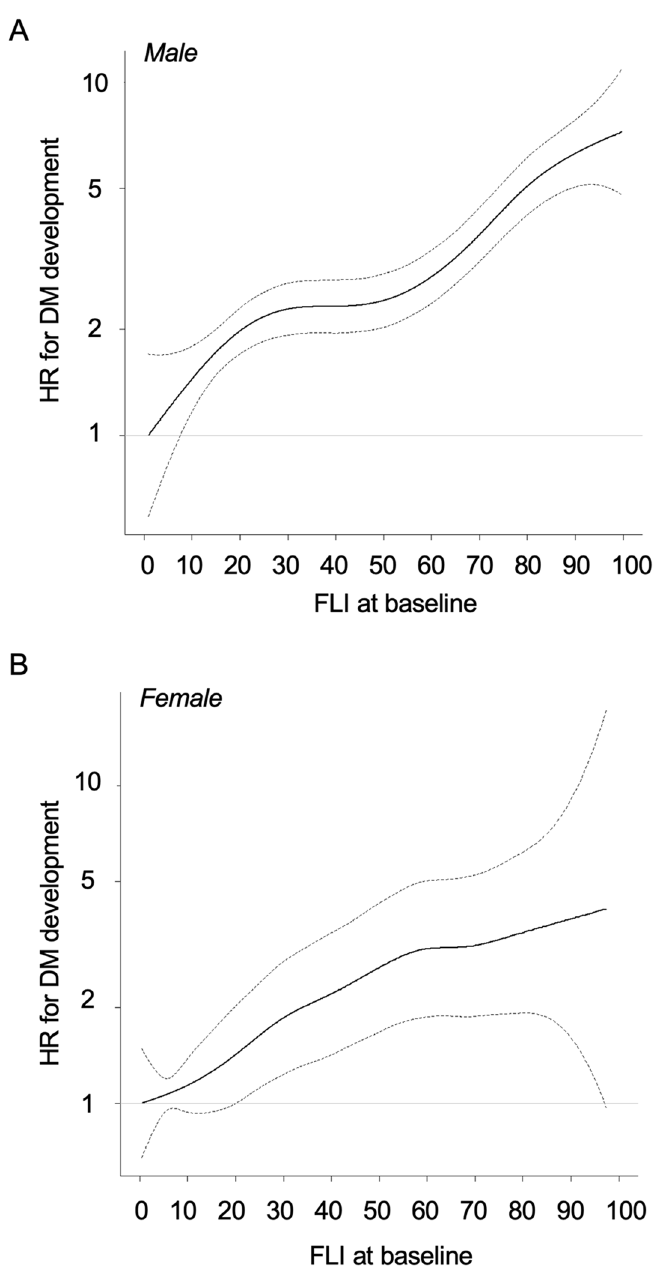
Figure 3. Hazard ratio of the development of DM by FLI at baseline. ( A , B) Hazard ratios (HRs) for the development of diabetes mellitus (DM) by fatty liver index (FLI) at baseline by multivariable Cox proportional hazard models with a restricted cubic spline in males ( A ) and females ( B ) after adjustment of age, fasting plasma glucose, habits of smoking and alcohol drinking, family history of DM, and diagnosis of hypertension and dyslipidemia at baseline during a 10-year follow-up period. Solid line: HR, dashed line: 95% confidence interval (CI). The reference values of FLI in males and females were 0.9 and 0.4 as minimum values,